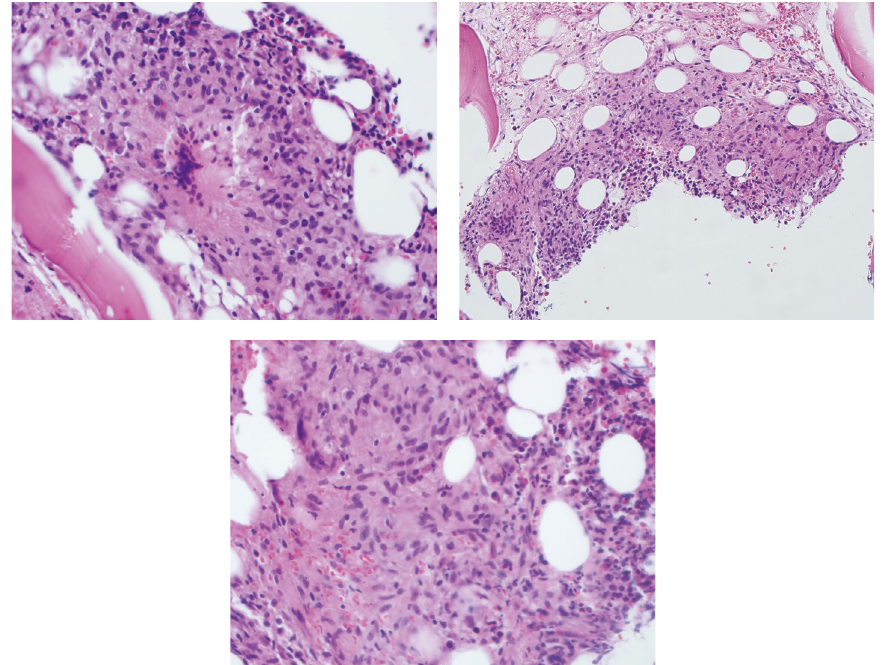
Figure 3: Biopsy of humeral lesions demonstrating noncaseating